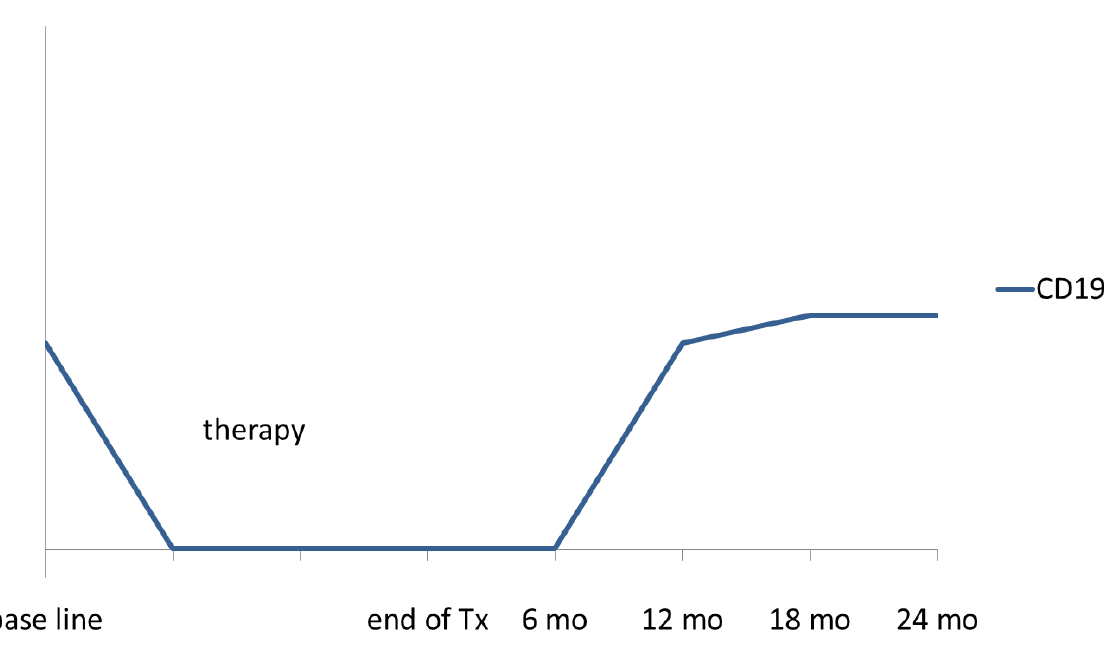
Figure 1. Schematic presentation of CD19 lymphocytes count in peripheral blood in NHL patients treated with